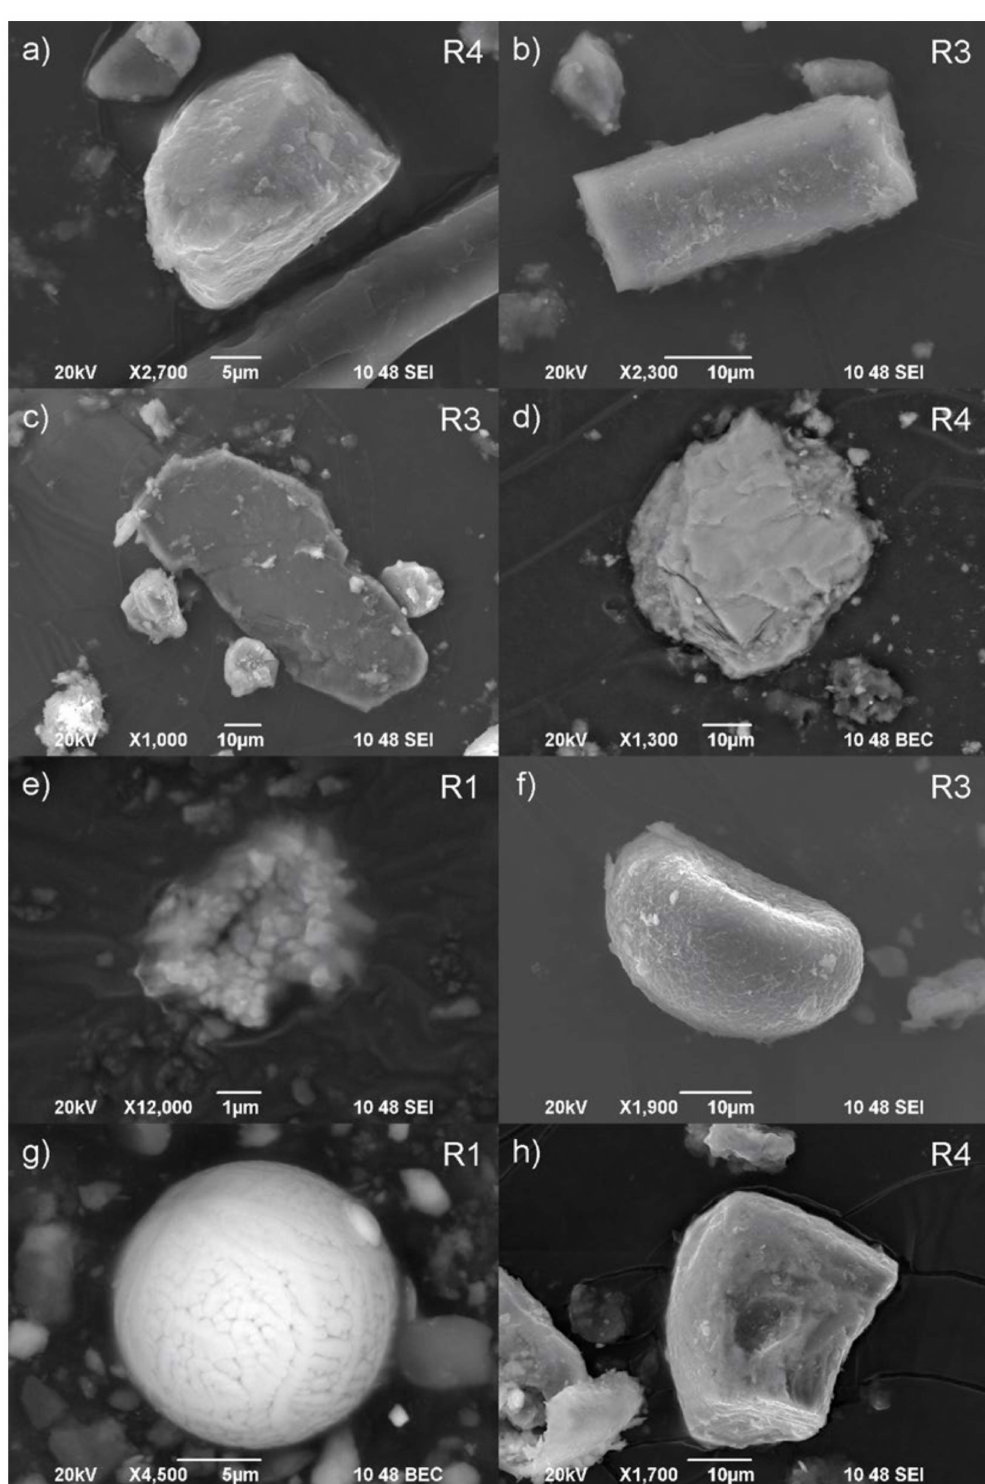
Figure 6. Particles from rainwater. Presented images are taken in SEI or BSE modes as indicated in the lower right corner of images. The sample code is marked in the upper right corner of each figure. ( a , b ) angular Si-O (quartz); ( c ) aluminosilicates with simple composition (Al-Si-O); ( d ) an- gular aluminosilicate (Si-Al-K-O); ( e ) crystalline structure of Ca-C-O particle (calcite or aragonite); ( f ) organic particle, spore; ( g ) Fe-O (Fe-oxyhydroxide) skeletal-dendritic sphere; ( h ) angular Zr-Si-O particle